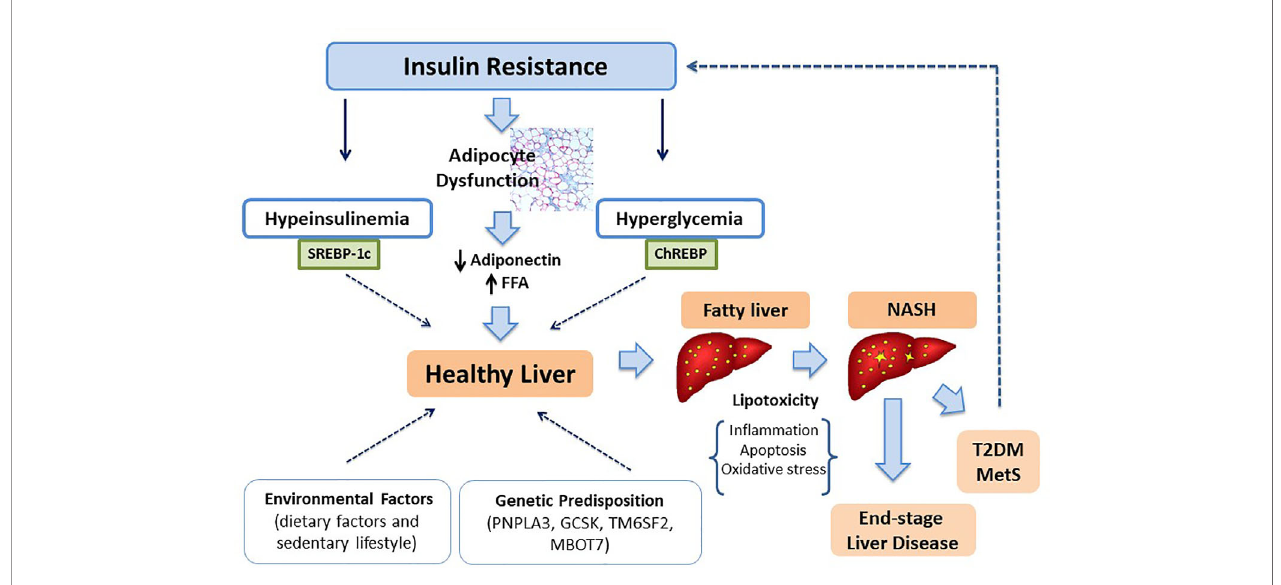
FIGURE 1 | The role of IR in NAFLD development and